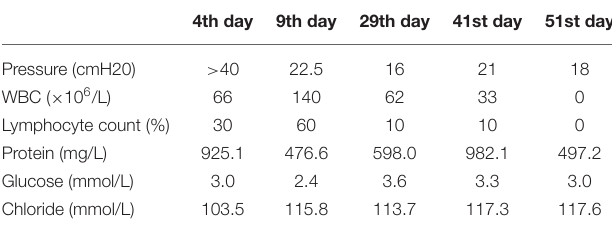
cryptococcal antigen and bacterial and fungal cultures, as well as results of the purified protein derivation test and sputum cultures, were all negative. High-throughput sequencing of the CSF detected Mycobacterium tuberculosis with high confidence.